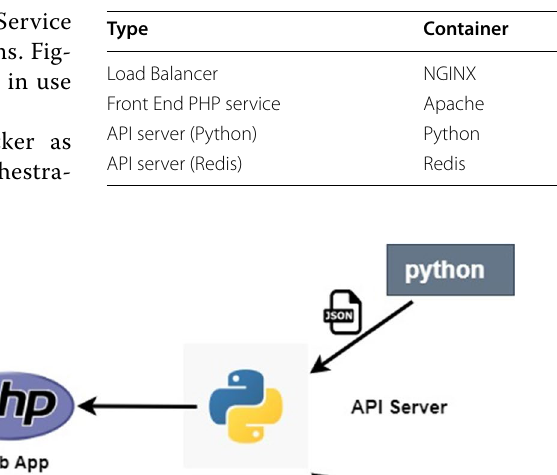
Table 1 Docker Swarm services for big data